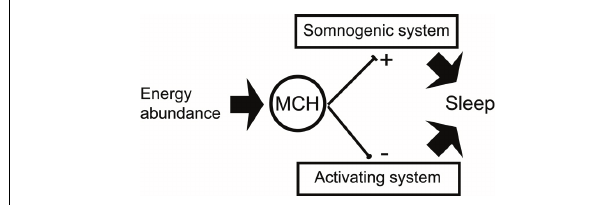
FIGURE 4 |The schematic shows a simple structural model that proposes a tentative mechanism by which MCH promotes sleep. During wakefulness MCHergic neurons may be activated during special conditions such as energy abundance. Inhibiting and facilitating the activating and somonogenic (SWS and REM sleep neuronal networks) respectively, MCH would facilitate and maintain